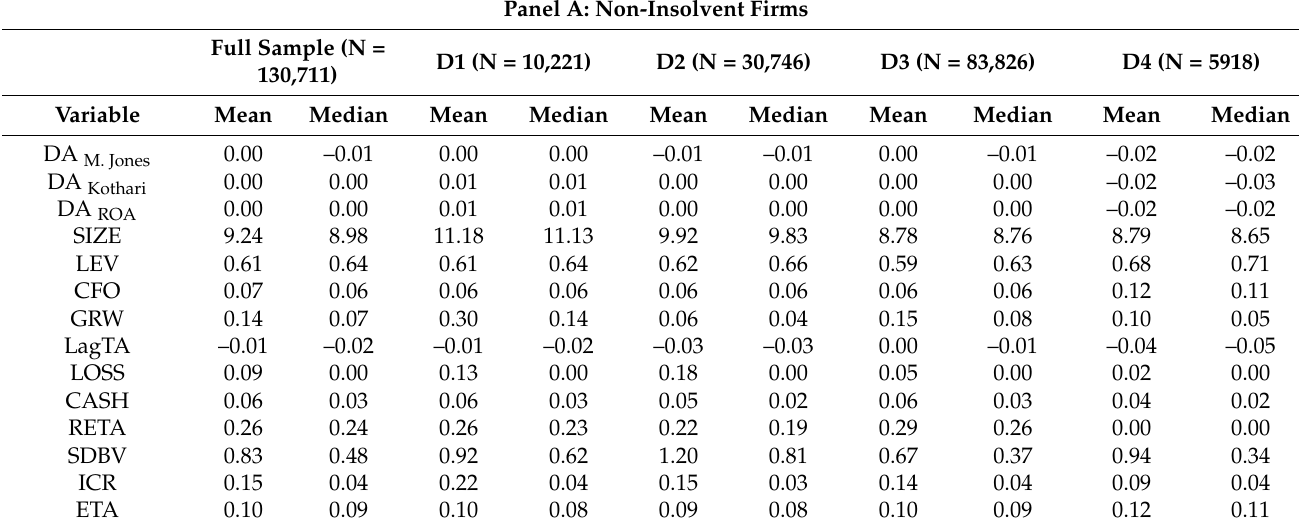
Table 5. Descriptive statistics according to insolvent